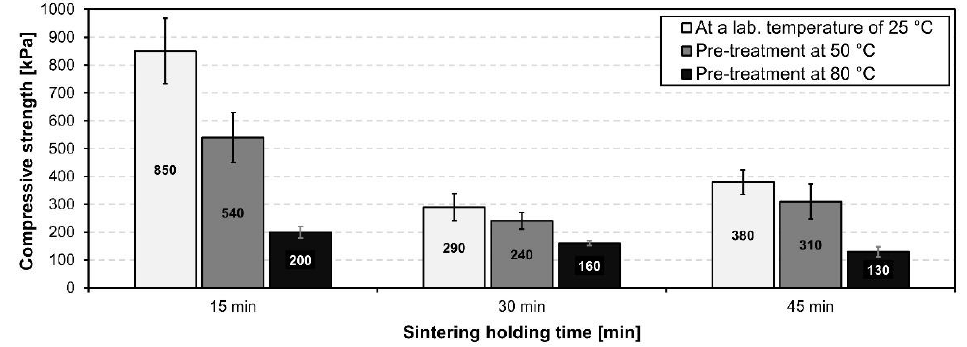
Figure 12. Compressive strength of prepared foam samples fired at 850 °C with different sintering holding times of 15, 30 and 45